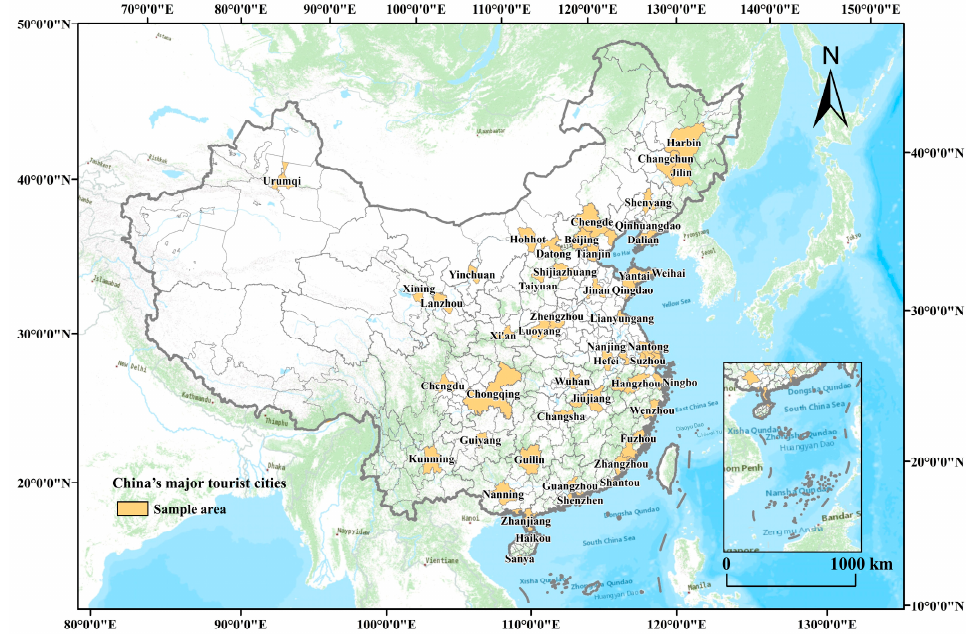
Figure 1. Spatial distribution of 58 major tourist cities in China.